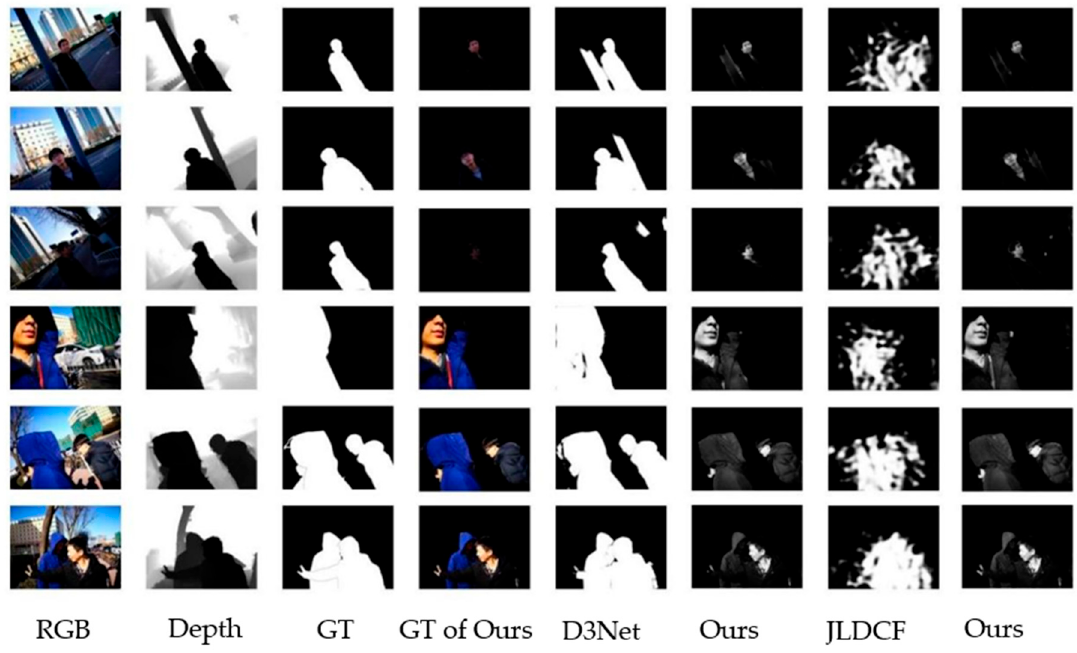
Figure 4. Visual comparison of our method with the traditional salient object detection methods on D3Net and JLDCF.